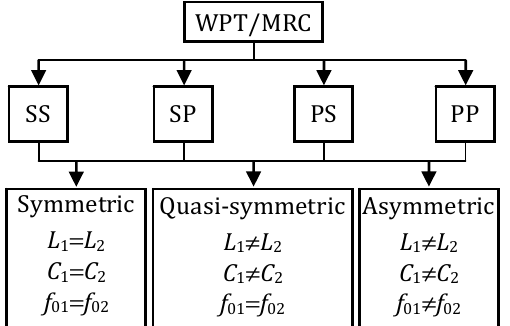
Figure 1. The magnetically coupled resonant wireless power transmission (WPT/MRC) system classification. Series-series (SS), series-parallel (SP), parallel-series (PS), and parallel-parallel (PP) compensated structures.